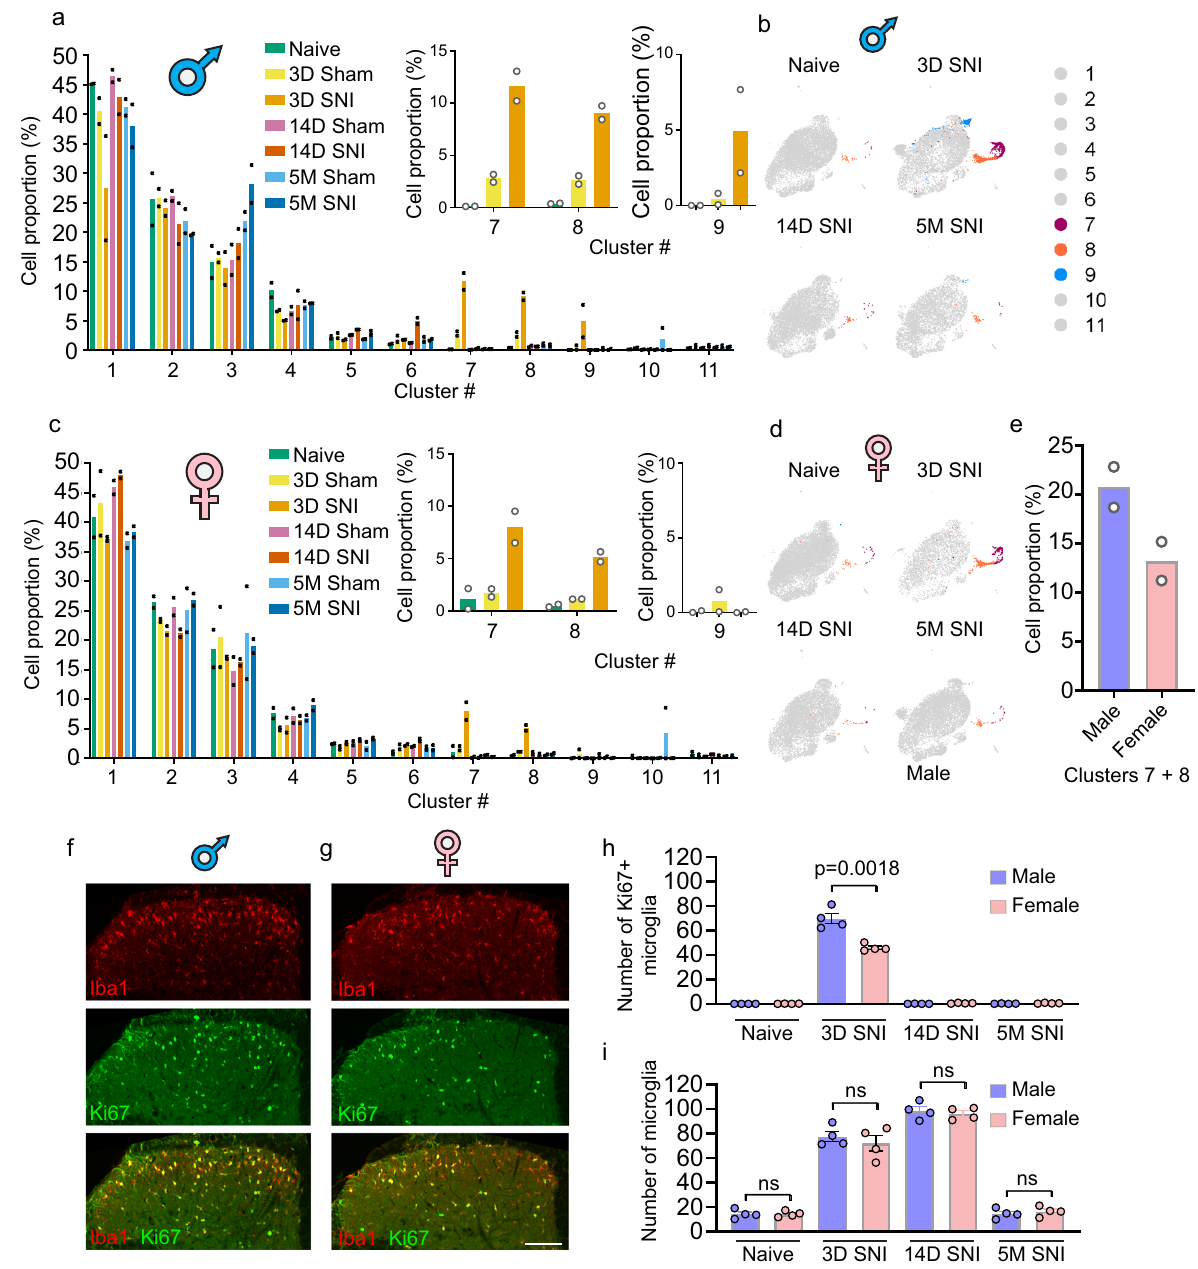
Fig. 2 Peripheral nerve injury induces changes in proportions of speci fi c microglia subpopulations. Proportion of microglia in each cluster in males ( a ) and females ( c ) is shown. Insets show the proportions of cells in clusters 7, 8, and 9. UMAPs of indicated conditions in males ( b ) and females ( d ), highlighting in color cluster 7, 8, and 9. e Proportion of microglia in clusters 7 and 8, combined, at day 3 post-SNI. Iba1 (microglia, red) and Ki67 (proliferating cells, green) immunostaining reveal proliferating microglia at day 3 post-SNI in males ( f ) and females ( g ). Similar results were obtained in two independent experiments. h Quanti fi cation of proliferating microglia ( n = 4 mice/group, 3D SNI: male versus female, t(6) = 5.342, p = 0.0018, unpaired two-tailed t -test). i Quanti fi cation of total number of microglia ( n = 4 mice/group, ns (non-signi fi cant) indicates p > 0.05, unpaired two-tailed t -test). Data are plotted as mean ± s.e.m. Scale bar is 100 μ